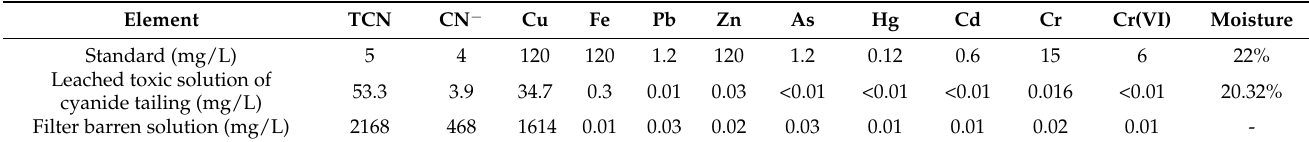
Table 2. Storage standard of cyanide tailings and element content table of cyanide tailing slurry.